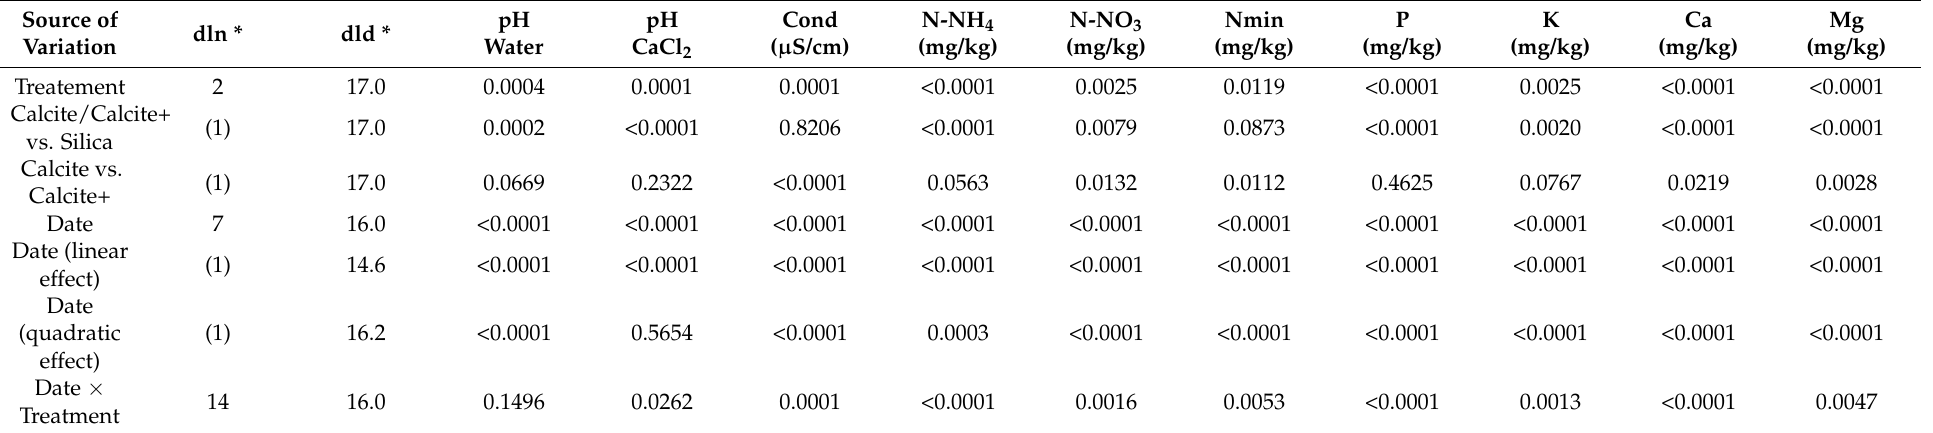
Table 2. Observed probabilities ( p -values) and degrees of freedom of the fixed effects associated with the analysis of variance of the fertility and physicochemical variables of the growing media depending to the covering material (Silica, Calcite and Calcite+) during the first growing season of white spruce seedlings (1 +